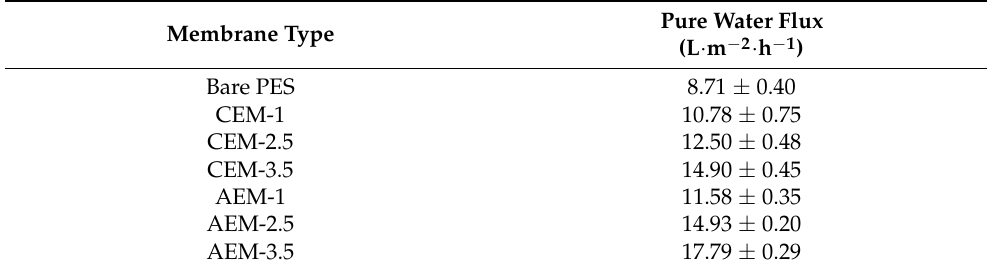
Table 4. Pure water flux of the prepared PES membrane, CEMs and AEMs at 0.5 bars in a dead-end filtration